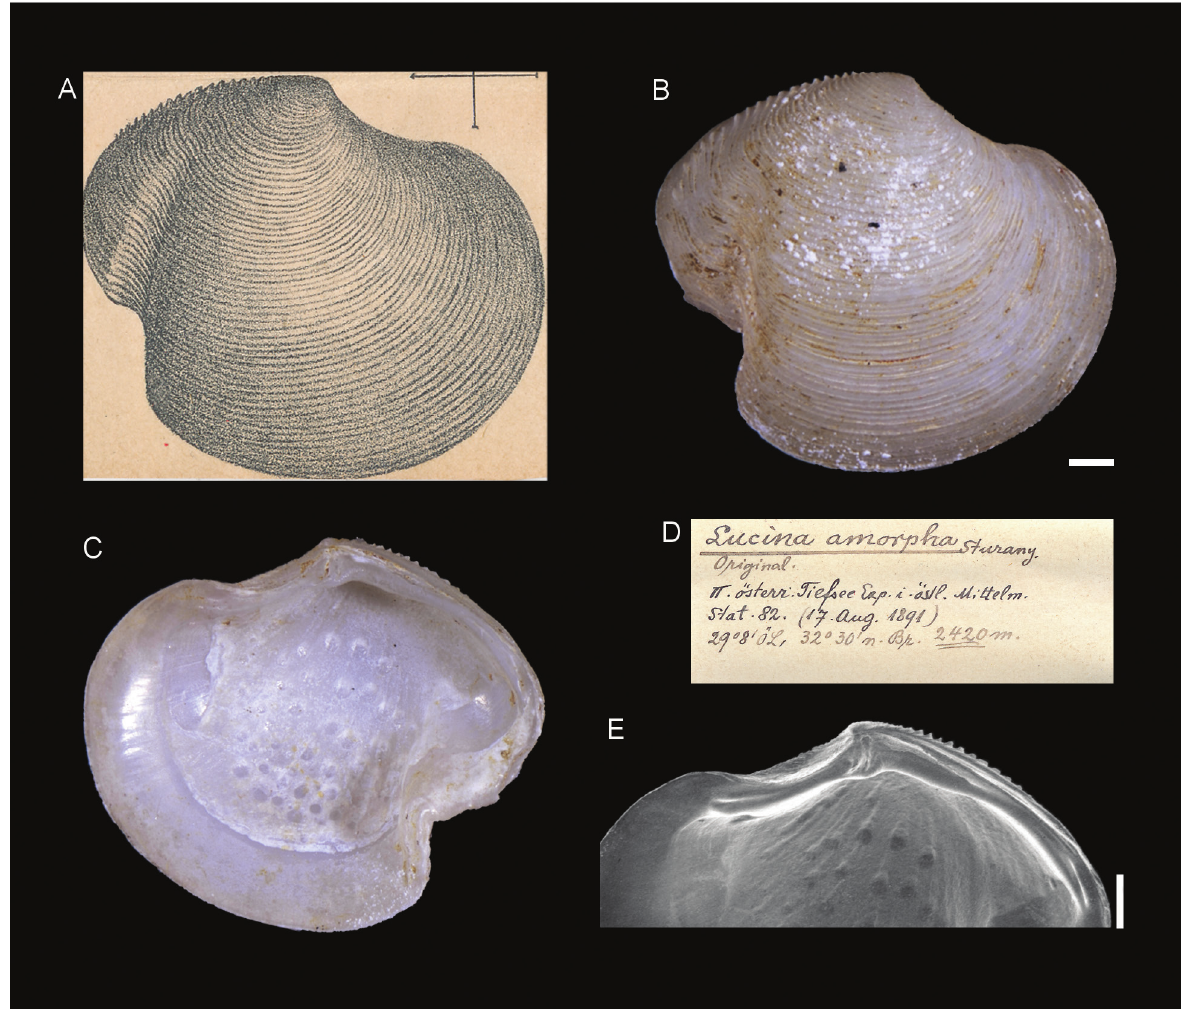
Figure 11. Lucina amorpha Sturany, 1896, station 82, north of Alexandria, Egypt, 2420 m. A . Original figure in Sturany, 1896. B , C , E . Holotype NHMW 13008: outer ( B ) and inner ( C ) views, hinge ( E ). D . Original label. Scale bar: 1 mm.